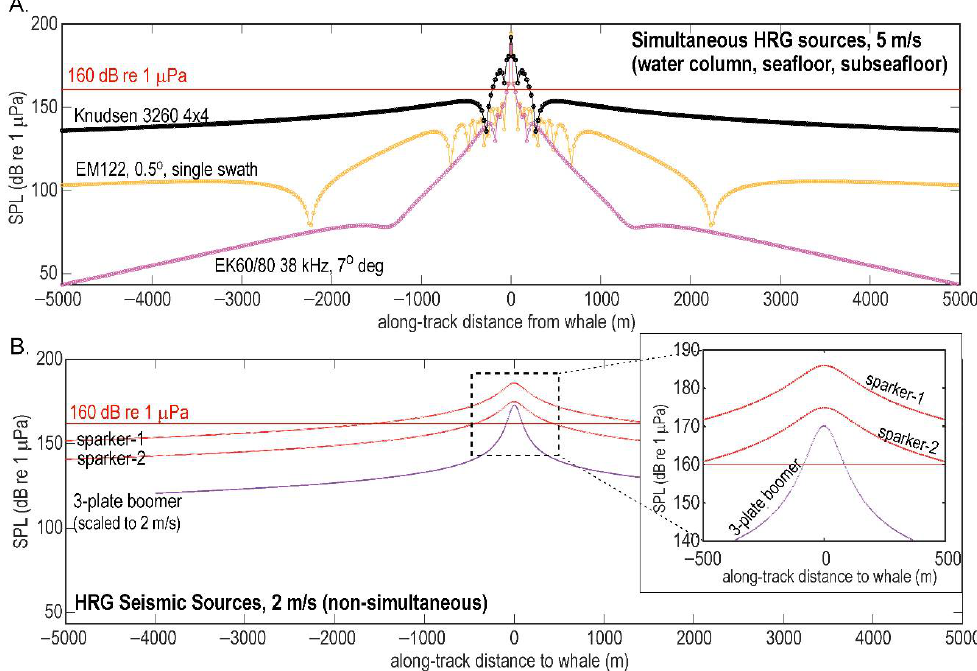
Figure 14. SPL for stationary animal at 100 m water depth, with sources color-coded as in Figures 4 and 10. ( A ) Composite of models for the maximum SL of the EM122, Knudsen 3260, and EK60/80 with 38 kHz transducer, using the parameters described in the text and listed in Table S2. The EM122 and Knudsen results are the same as in Figures 11 and 12, respectively, and degree of exposure information is provided for all 3 sources in Figure 10. Intermediate and global class research vessels often use simultaneous sources with synchronized pinging to image the water column, seafloor, and subseafloor in a single pass. ( B ) Comparison for 3 HRG seismic sources towed at normal survey speeds (2 m/s; boomer model in Figure 13 adjusted to this survey speed, which increases exposure duration and number of pings exceeding 160 dB re 1 μPa by 20%) for these instruments. Scale is the same as in panel ( A ). The plot shows individual pings that can be more easily seen in the inset blowup figure, which corresponds to the dashed outlined portion in the center of the main plot. Sparker-1 has peak SL of the Delta sparker operated at 6 kJ [9] and sparker-2 is the SIG ELC 820 sparker operated at 700 J, a common power level for water depths less than 500 m.